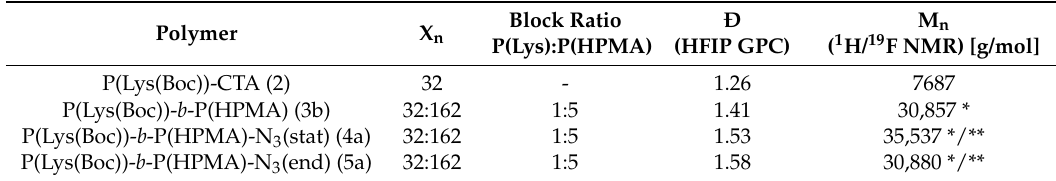
Table 1. Polymer characterization.